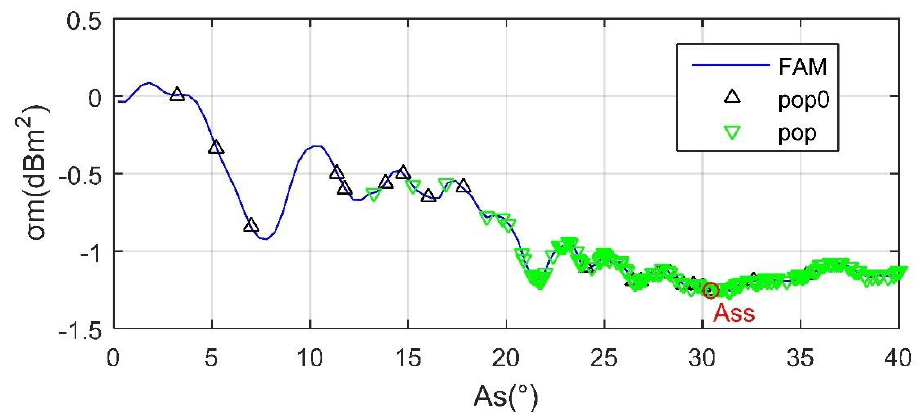
Figure 16. Comparison of optimal solutions for the aircraft, where α n = 80° , α m = 110°, β = − 10°, and F rh = 5 GHz.